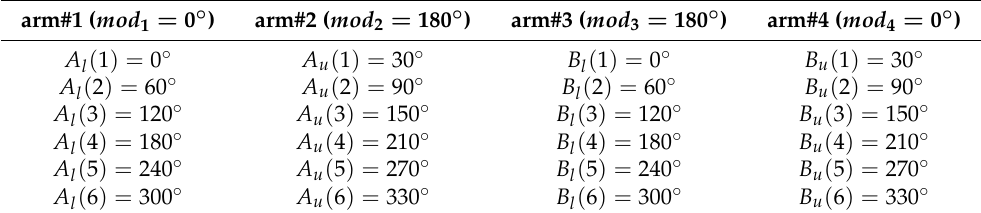
Table 1. PWM parameters for the bi-phase MMC with N = 6 SMs/phase of Figure 5.